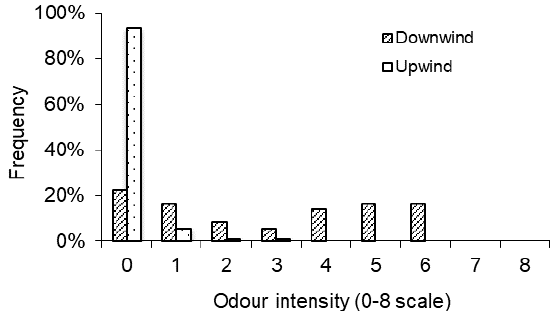
Figure 3. Odour intensity assessed by human sniffers upwind and downwind of the farm.